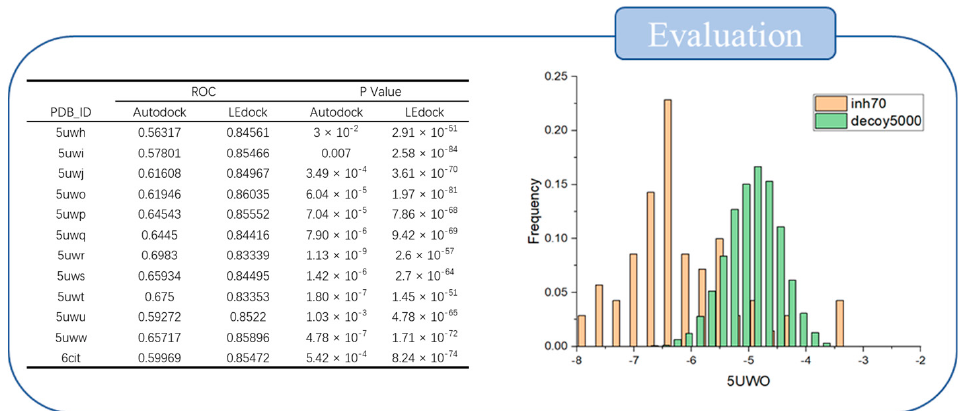
Figure 2. The evaluation results reveal that optimal screening proficiency was obtained using the 5UWO structure with LeDock software.